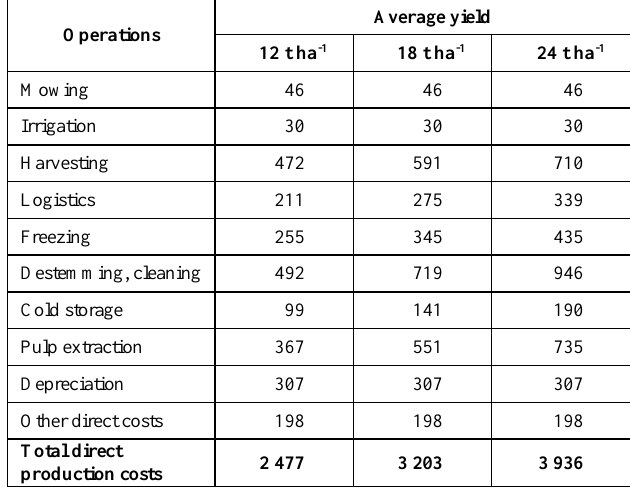
Table 3. Yearly production costs per operation at farm level in the case of various average yields (thousand HUF ha -1